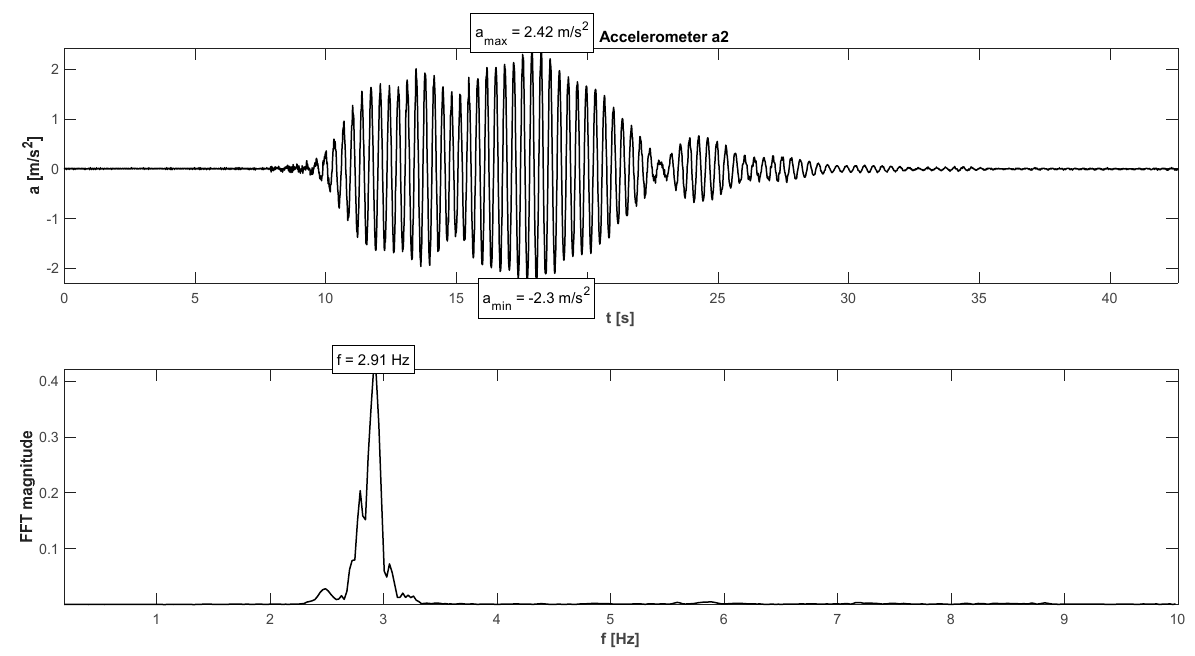
Figure 27. Signal of vertical vibrations in the time and frequency domain registered for the synchronized walking of 10 people.